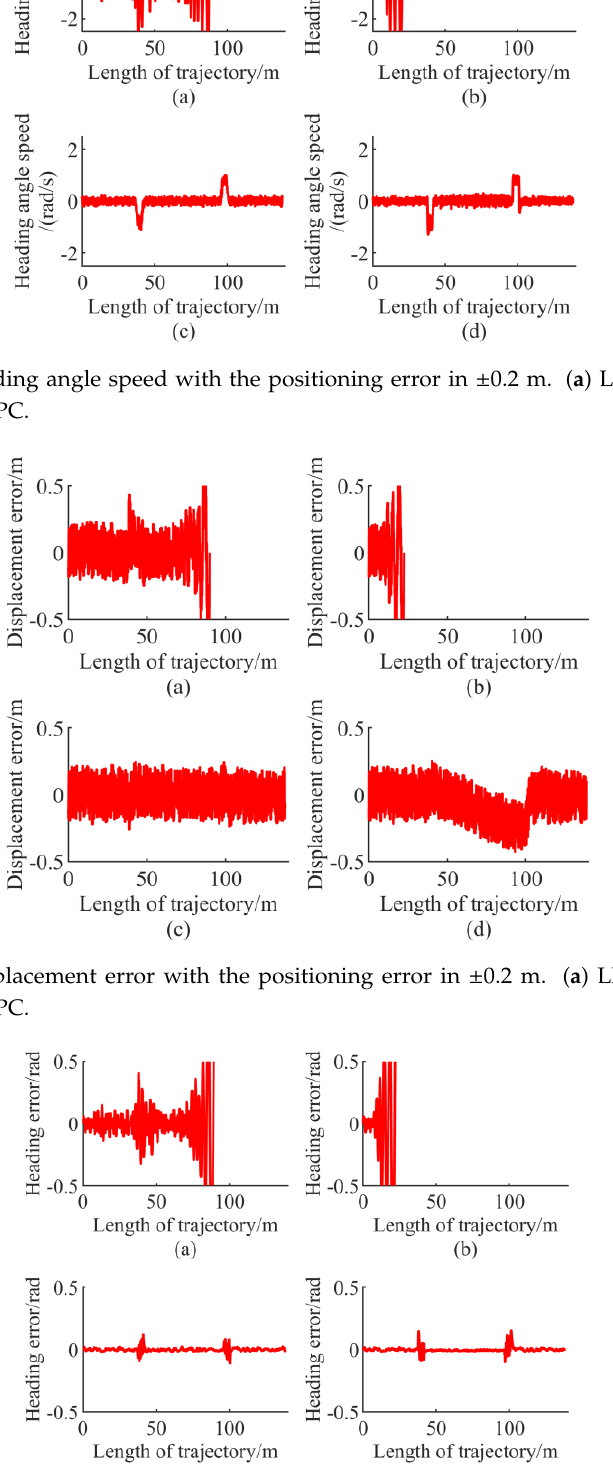
Figure 38. The computation time with the positioning error in ±0.2m. ( a ) LMPC. ( b ) LEMPC. ( c ) NMPC. ( d ) NEMPC. 4.3. Parameters Changed To avoid instability, we adjusted the weighting factor again and gave the final set of comparisons. Table 9 shows the new weight coefficients. The positioning error is set in ( − 0.2 m, 0.2 m). Figures 39 – 44 show the simulation results. The maximum absolute values of errors are shown in Table 10. After adjusting the weights, all of the controllers can control the mobile robot to complete the path tracking. However, the ability of LMPC and LEMPC to reduce residual errors is greatly diminished. The maximum absolute error of these two controllers is large. The maximum absolute values of errors are shown in Table 9. From these data, LMPC and LEMPC are less robust to positioning errors, but NMPC and NEMPC are robust to positioning errors. Table 9. Changed parameters in controllers. Symbol